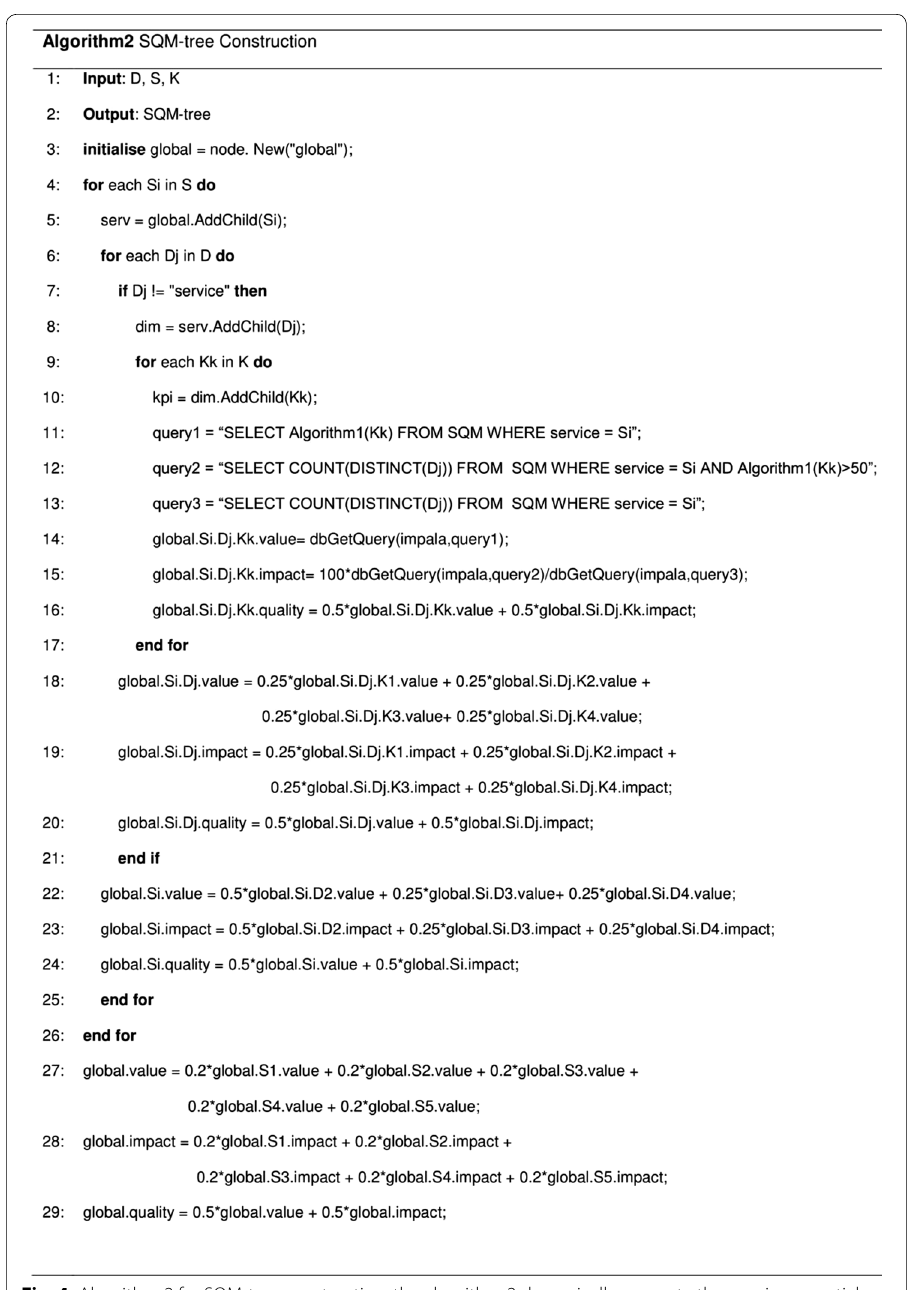
Fig. 4 Algorithm 2 for SQM-tree construction: the algorithm 2 dynamically generate the queries essential to construct and fill in the SQM tree. The queries are launched using an impala connector to the Big Data platform and the results of the KPIs are combined with some weights (considering the subscribers as the most important dimension) to derive the SQIs for each tree The second algorithm (algorithm 2) as shown in Fig. 4, was the algorithm used to con- struct the SQM-tree nodes based on the quadri-dimensional approach focusing on the four dimensions (Service, subscriber, handset and cell) and to dynamically build the Big Data queries to fill in the tree with both the KPIs and the aggregated SQIs data. All the